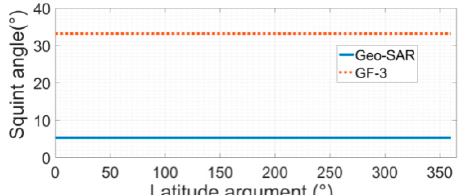
Figure 3. Squint angles (SA) comparison (IA= 45.5° and GSA = 60°). The solid blue line and dotted red line, respectively, represent Geo-SAR and GF-3. GF − 3 SA in one orbit period is about 33.2 degrees, while that of Geo − SAR is about 5.3 degrees.